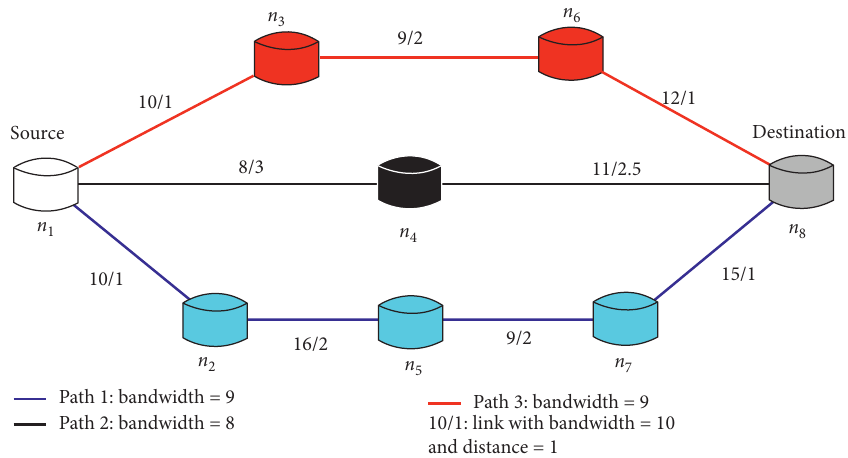
Figure 4: Incorrect routing decision in a case of multiple paths with the same